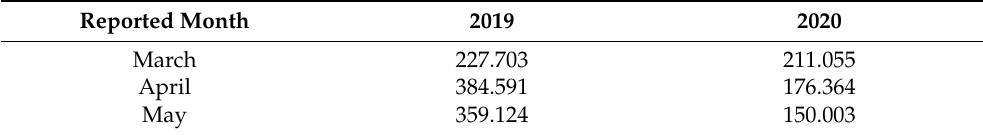
Table 4. Hexavalent vaccine supply in 2019 and 2020 ((Vaccine stocks according to National Center for Study and Control for Infectious Diseases accessed at: